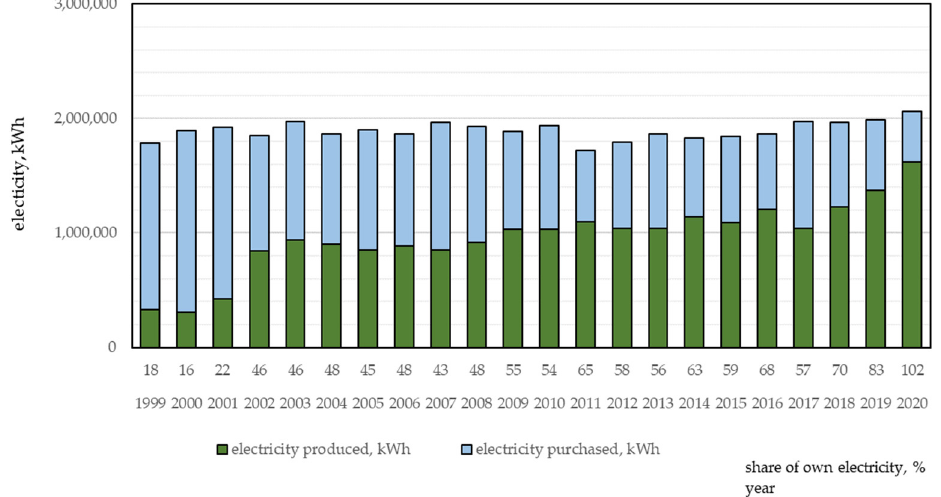
Figure 7. Electricity produced and purchased from the grid in the years 1999 – 2021 .